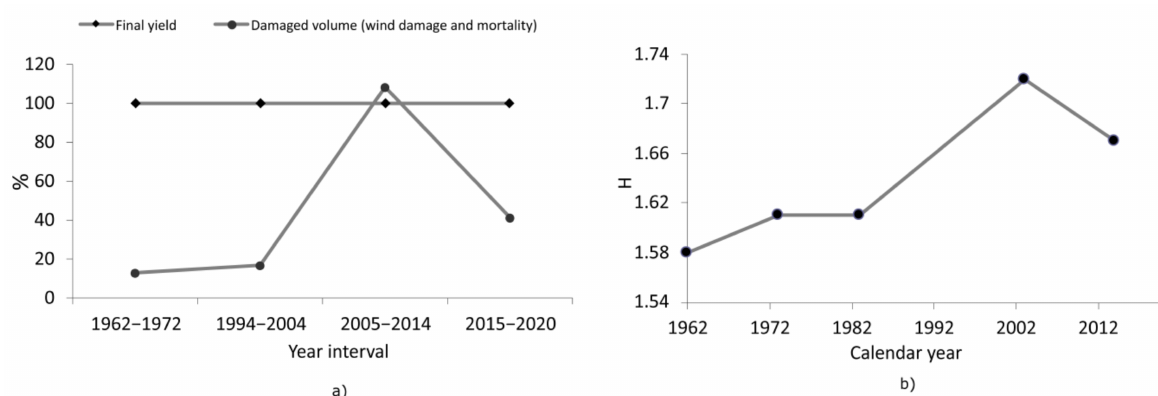
Figure 6. Volume of wood from wind damage and deadwood compared to the level of yield production (i.e., annual allowable cut) ( a ) and the Shannon index values at the unit management level in 1962–2020 ( b ). For 2020, the Shannon index values came from the composition of the forest as determined by the inventory works. For previous years, the values were determined based on information provided by the forest management plans. The 2015–2020 damaged wood volume was estimated based on data obtained from permanent plot measurements.